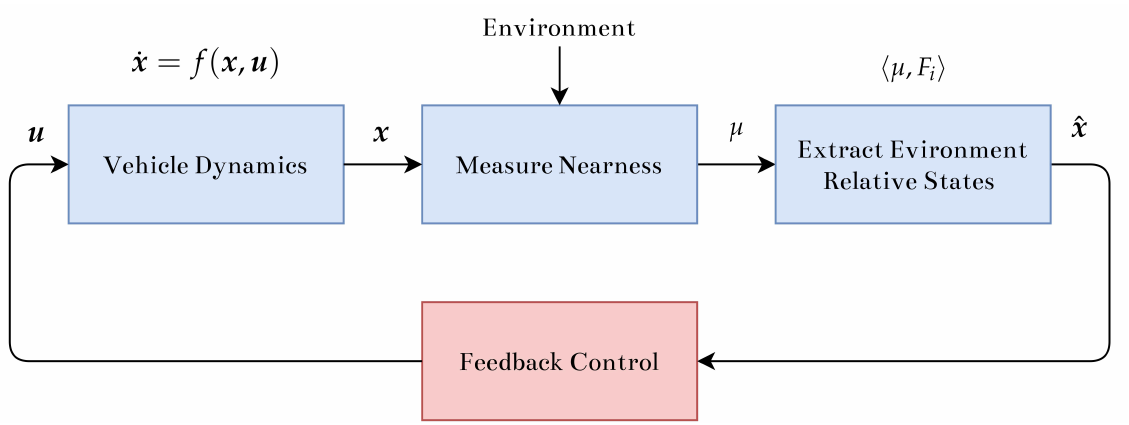
Figure 2. Process flow diagram demonstrating interactions between main subsystems. Nearness is measured from environment and environment relative states are extracted and used for control feedback, ultimately affecting vehicle